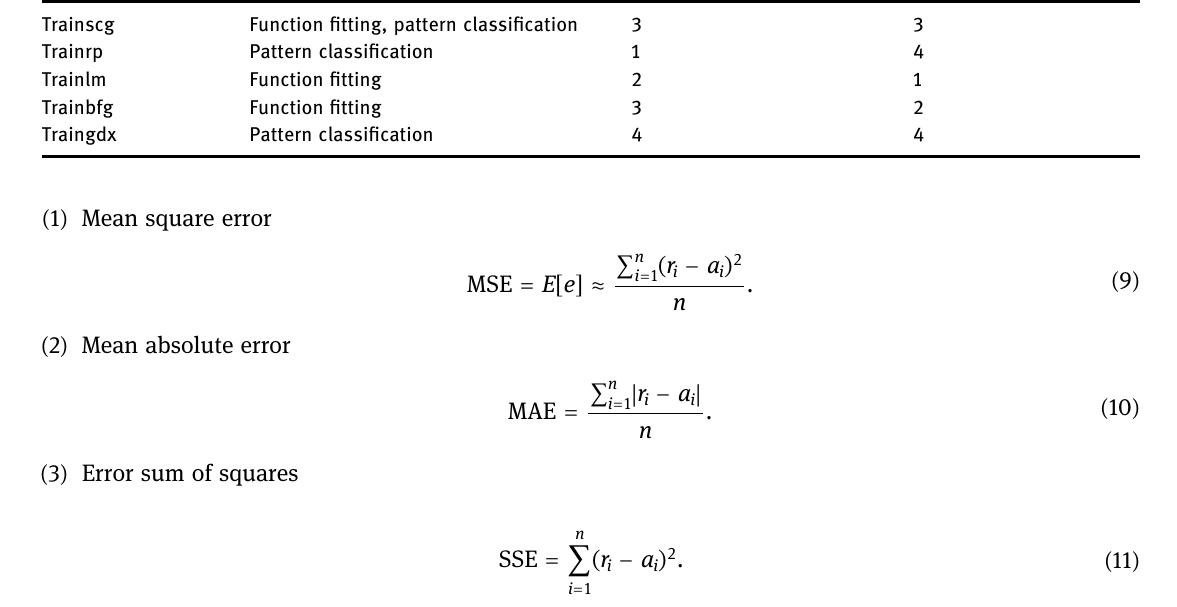
Table 2: Comparison of several typical learning functions Learning